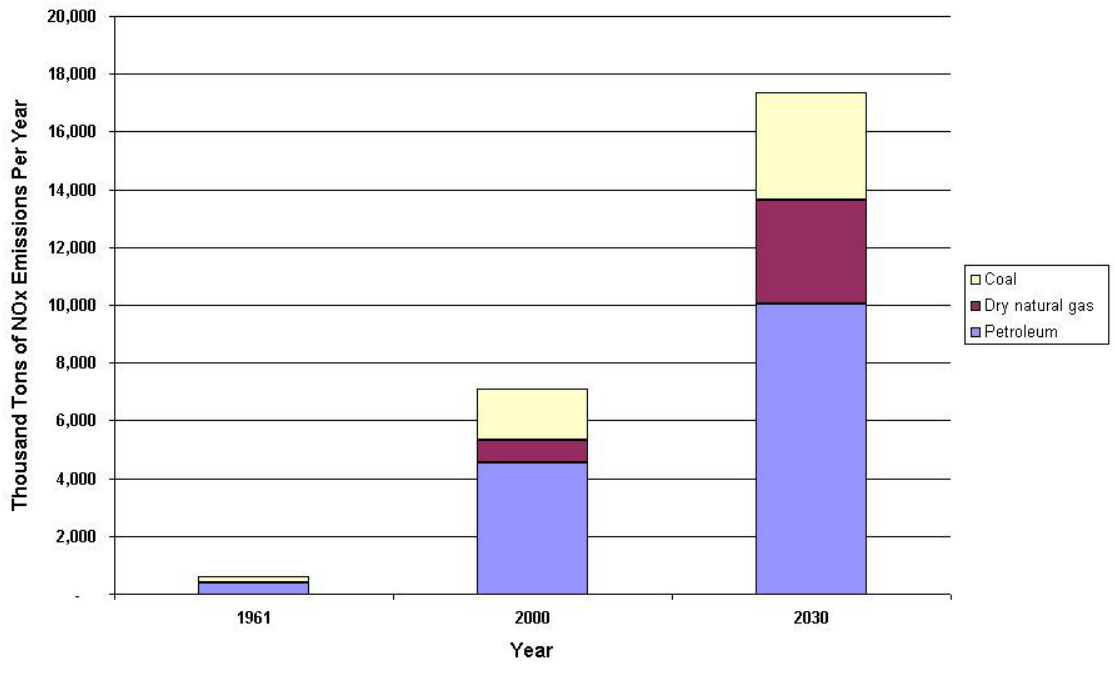
FIGURE 3. NO emissions in Asia from fossil energy consumption in the years 1961, 2000, and 2030 (from plenary presentation by W. Bradley). Zheng, X., Huang, x Y., Xu, X., Wang, Y., Han, S., and Hu, F. (2001) Potential stresses of Asian agricultural activities on the environment: an analysis from nitrogen cycle point of view. Global Change Biology ,